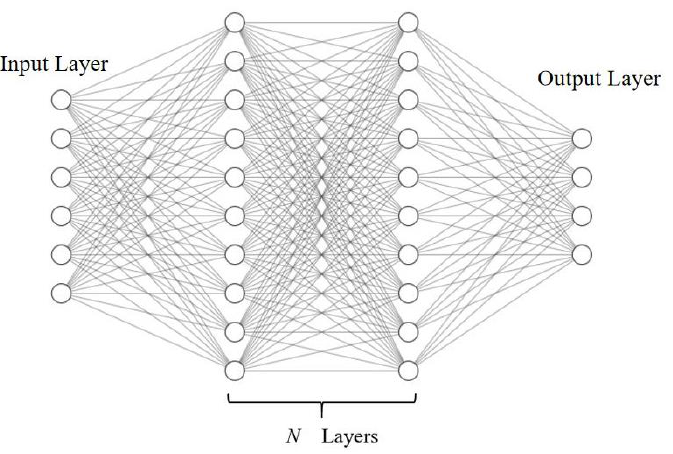
Figure 7. The architecture of the neural network.